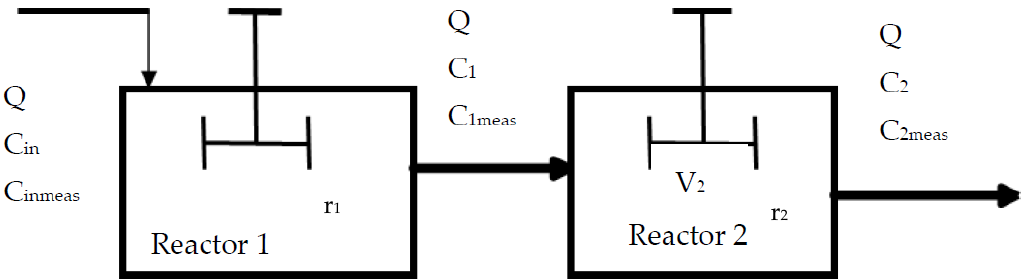
Figure 6. Schematic representation of the combined system.